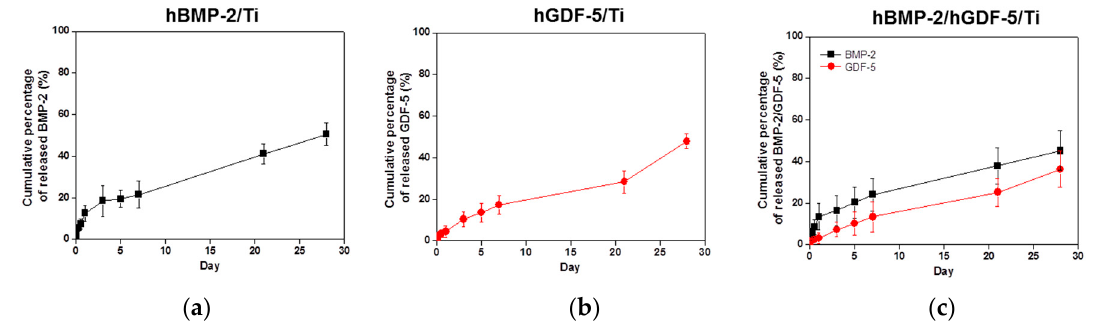
Figure 4. Release behavior of hBMP-2 from ( a ) hBMP-2/Ti; ( b ) hGDF-5/Ti; and ( c ) hBMP-2/hGDF-5/Ti samples in PBS (pH 7.4) monitored for 30 days. The error bars represent mean ± SD ( n = 3). This experiment was repeated three times.